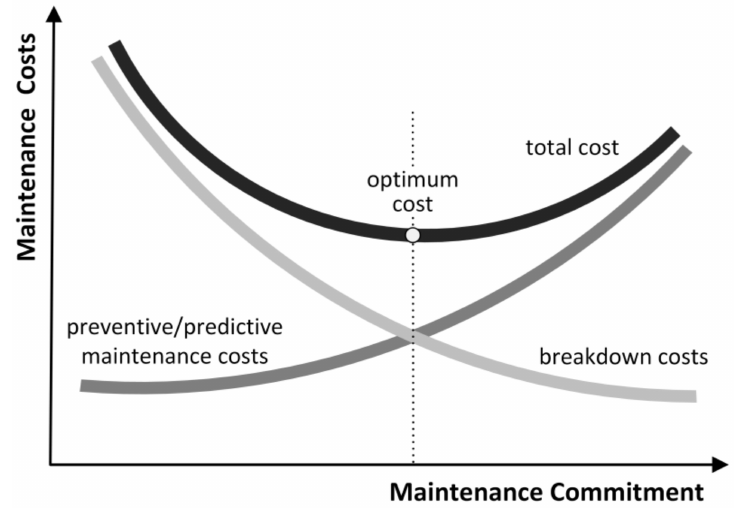
Figure 1. Maintenance Cost vs. Maintenance Commitment indicating the optimum point of Total Maintenance